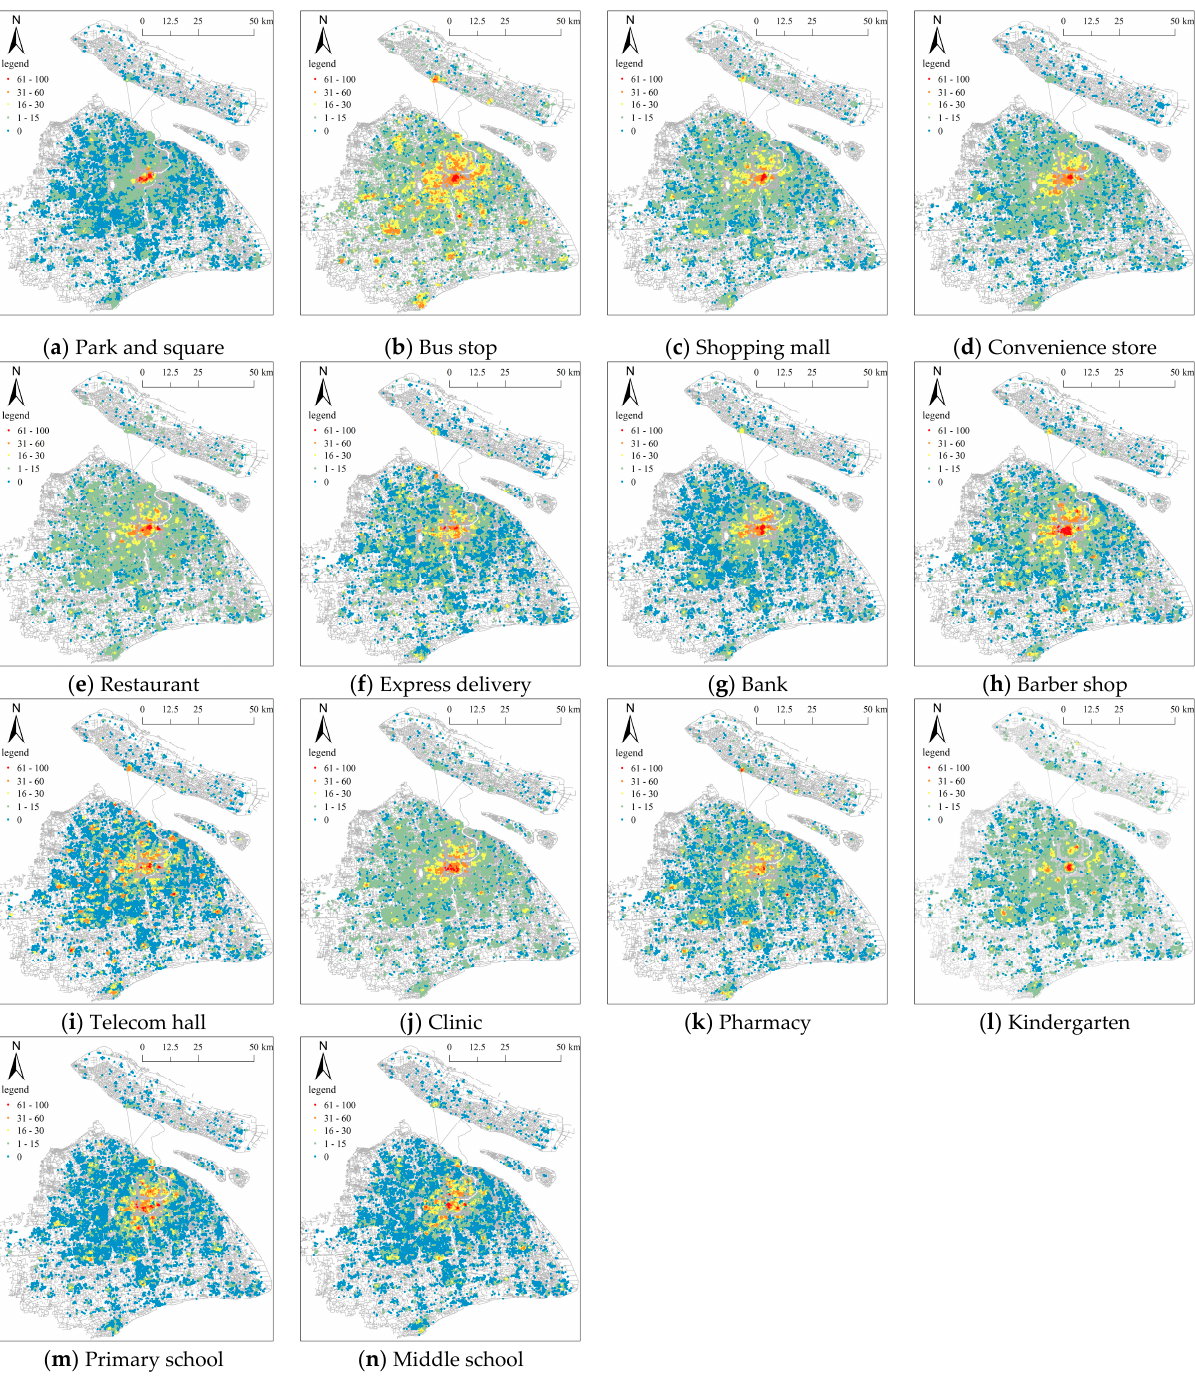
Figure 2. Walking score analysis charts of different facilities. (a) Park and square; (b) Bus stop; (c) Shopping mall; (d) Convenience store; (e) Restaurant; (f) Express delivery; (g) Bank; (h) Barber shop; (i) Telecom hall; (j) Clinic; (k) Pharmacy; (l) Kindergarten; (m) Primary school; (n) Middle school. As shown in Figure 2, each colored point in the figure indicates a community. Ac ‐ cording to the graded walking score to different facilities, the blue community point with a walking score of zero indicates that the community cannot reach that type of facility